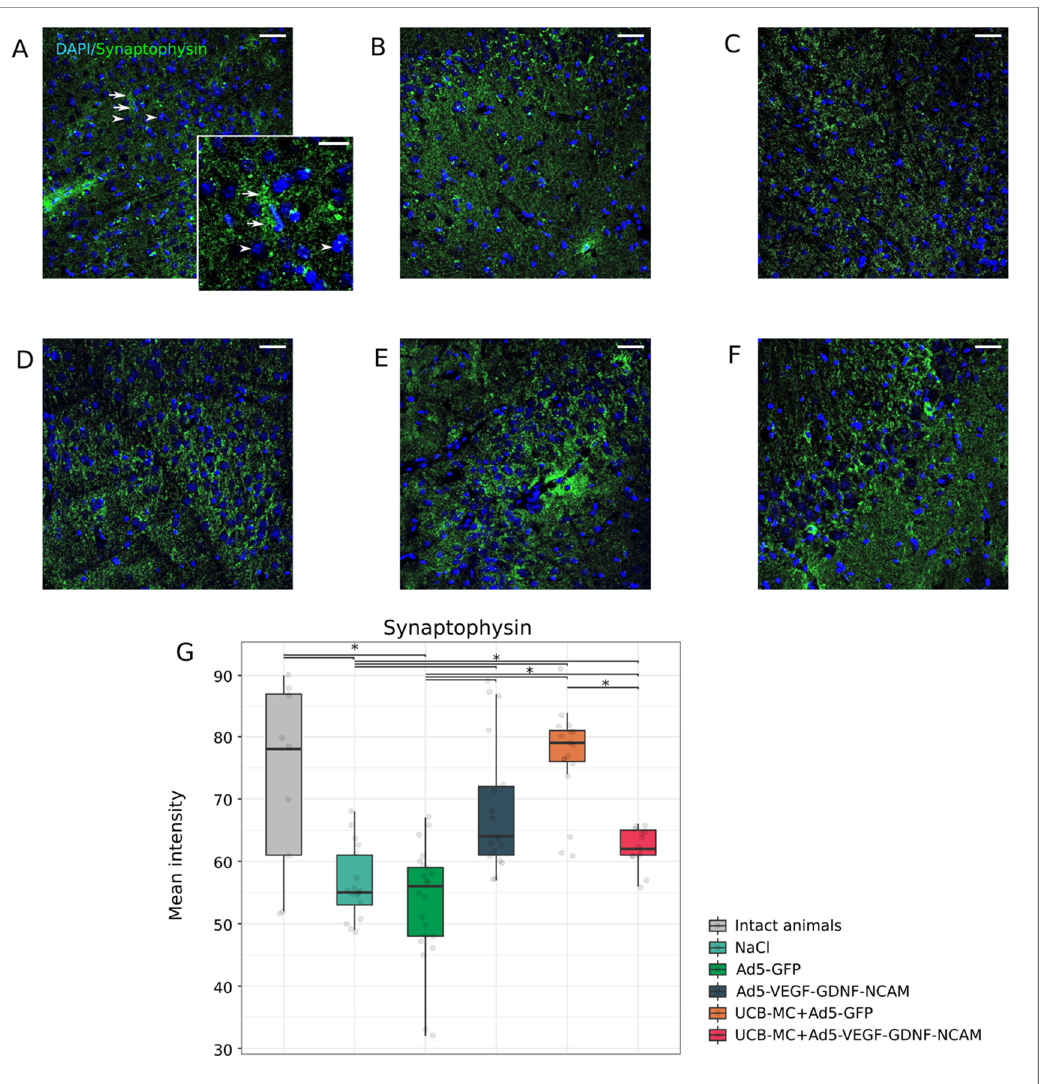
Figure 8. Immunoexpression of Synaptophysin in the rat brain cortex, 21 days after the middle cerebral artery occlusion. Immunofluorescent staining with antibody to synaptic vesicle membrane protein Synaptophysin in intact ( A ), control NaCl ( B ) and Ad5-GFP ( C ), and therapeutic UCB-MC + Ad5-GFP ( D ), Ad5-VEGF-GDNF-NCAM ( E ) and UCB-MC + Ad5-VEGF-GDNF-NCAM ( F ) groups. Arrows indicate Synaptophysin (green glow) in neurons. Arrowheads point to cell nuclei visualized using DAPI (blue glow). Scale bar in ( A — F ) = 50 µ m; scale bar in the insert = 20 µ m. ( G )—comparative analysis of fluorescence intensity level of Synaptophysin in experimental groups; *— p < 0.05.